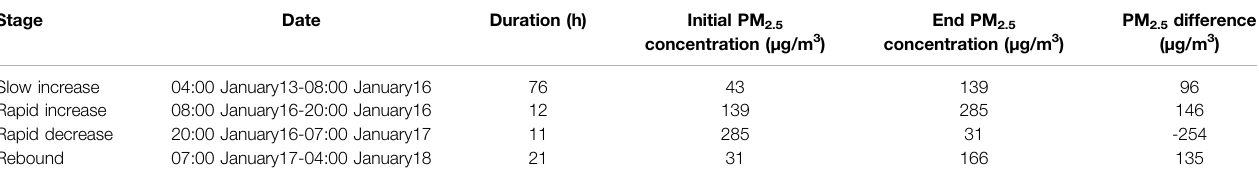
TABLE 1 | Summary of the different air pollution stages in Fuyang during the study period.